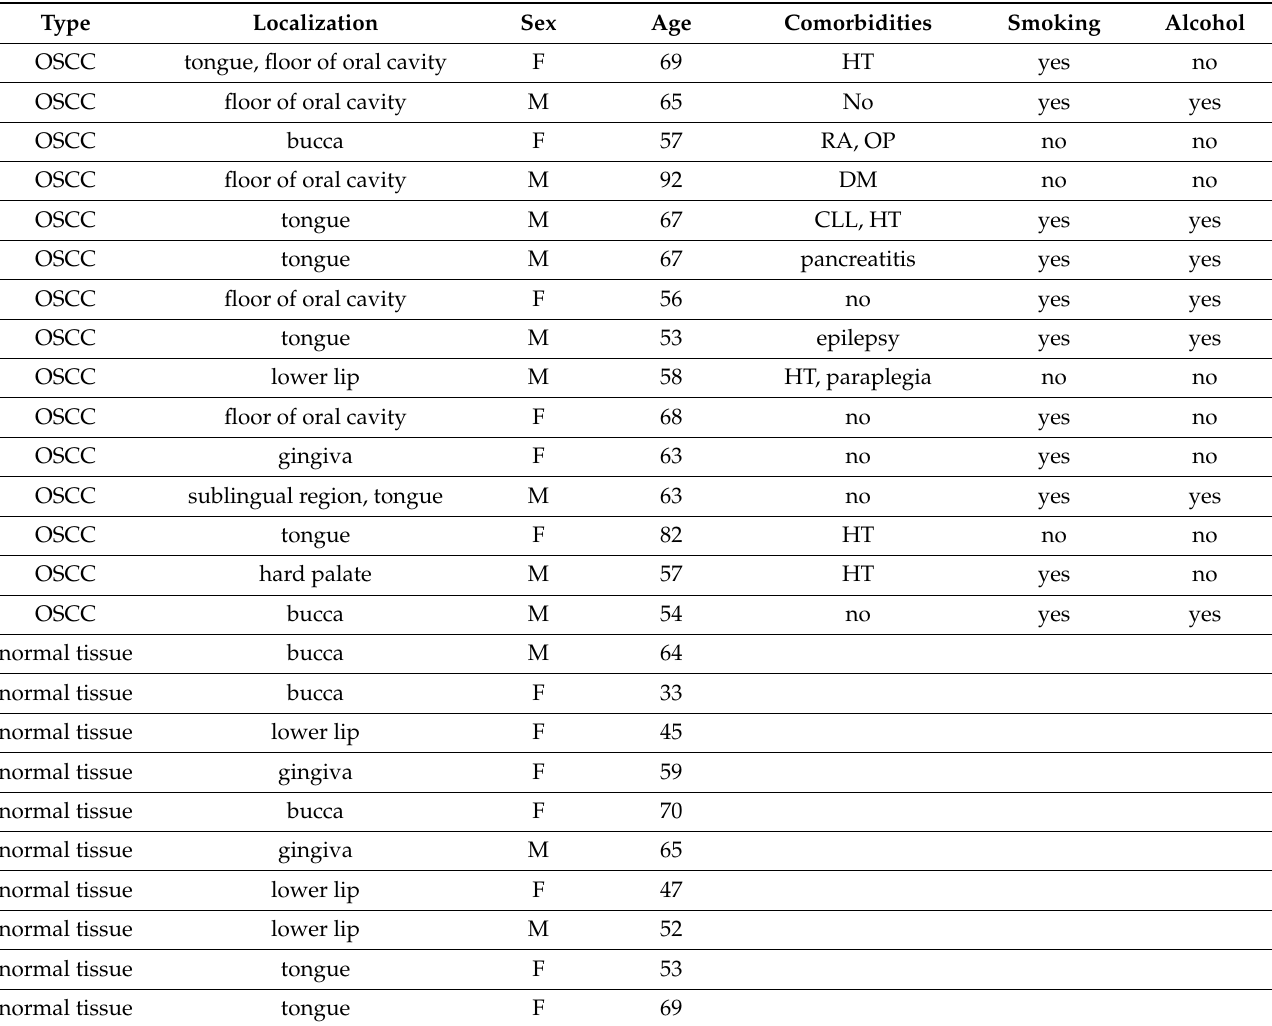
Table 1. Summary of the occurrence and demographics of the patients with histologically validated squamous cell carcinoma and control samples (M = male, F = female, HT = hypertonia, RA = rheuma- toid arthritis, CLL = chronic lymphoid leukemia, OP = osteoporosis, DM = diabetes